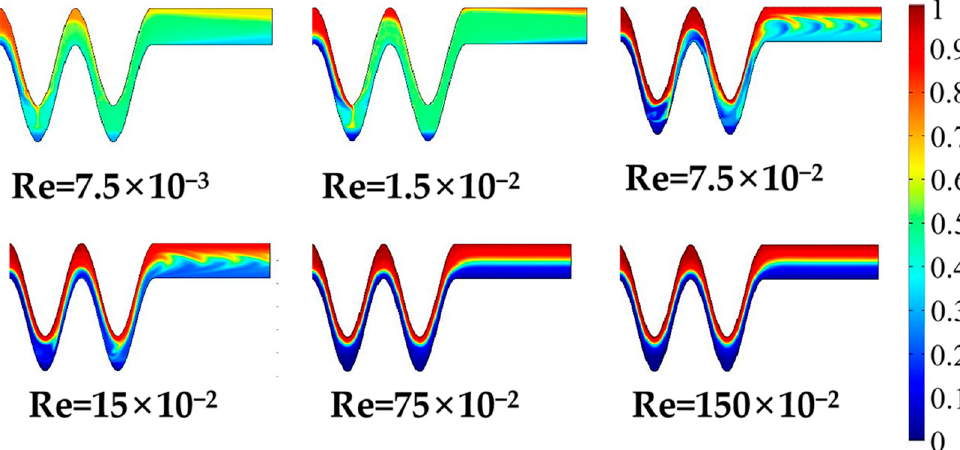
Figure 9. Distributions of concentration surface from the A-A section to the outlet of the micromixer for different inlet velocities when time t = 10 s, phase shift of pi/4, V 0 = 2 V, and f = 5 Hz.